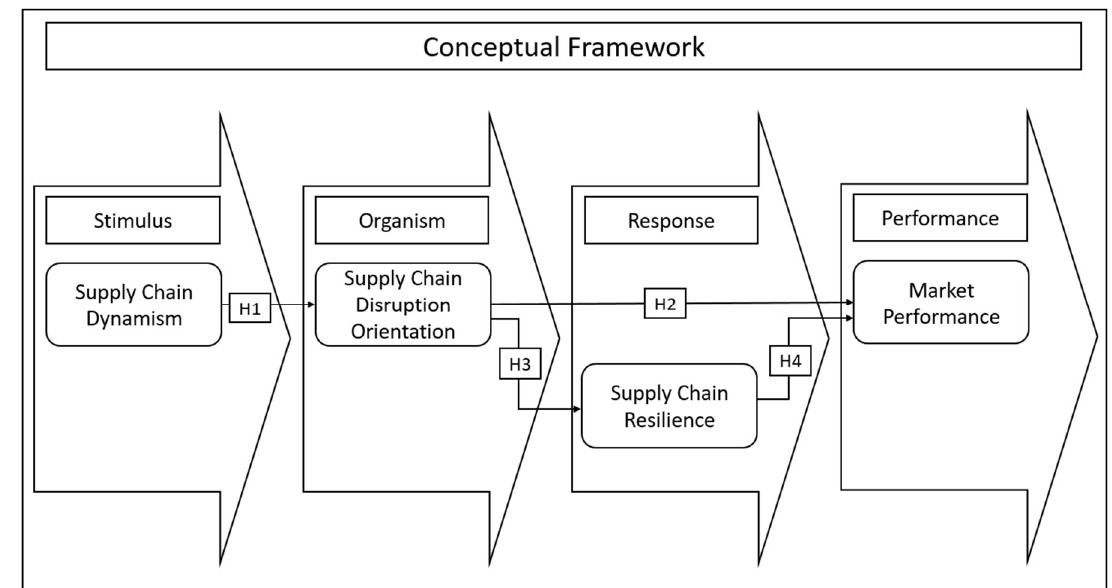
Figure 1. Conceptual Framework.